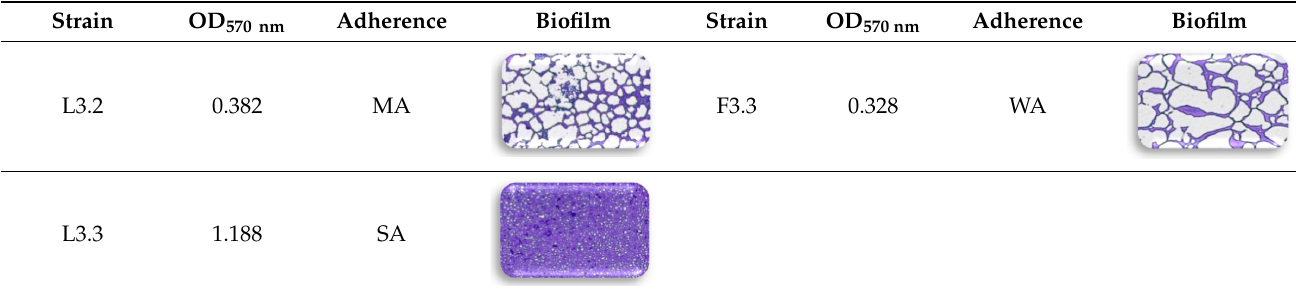
Figure 3. Detection of amp C β‐ lactamases gene and bla TEM and bla SHV β‐ lactam ‐ resistance genes.